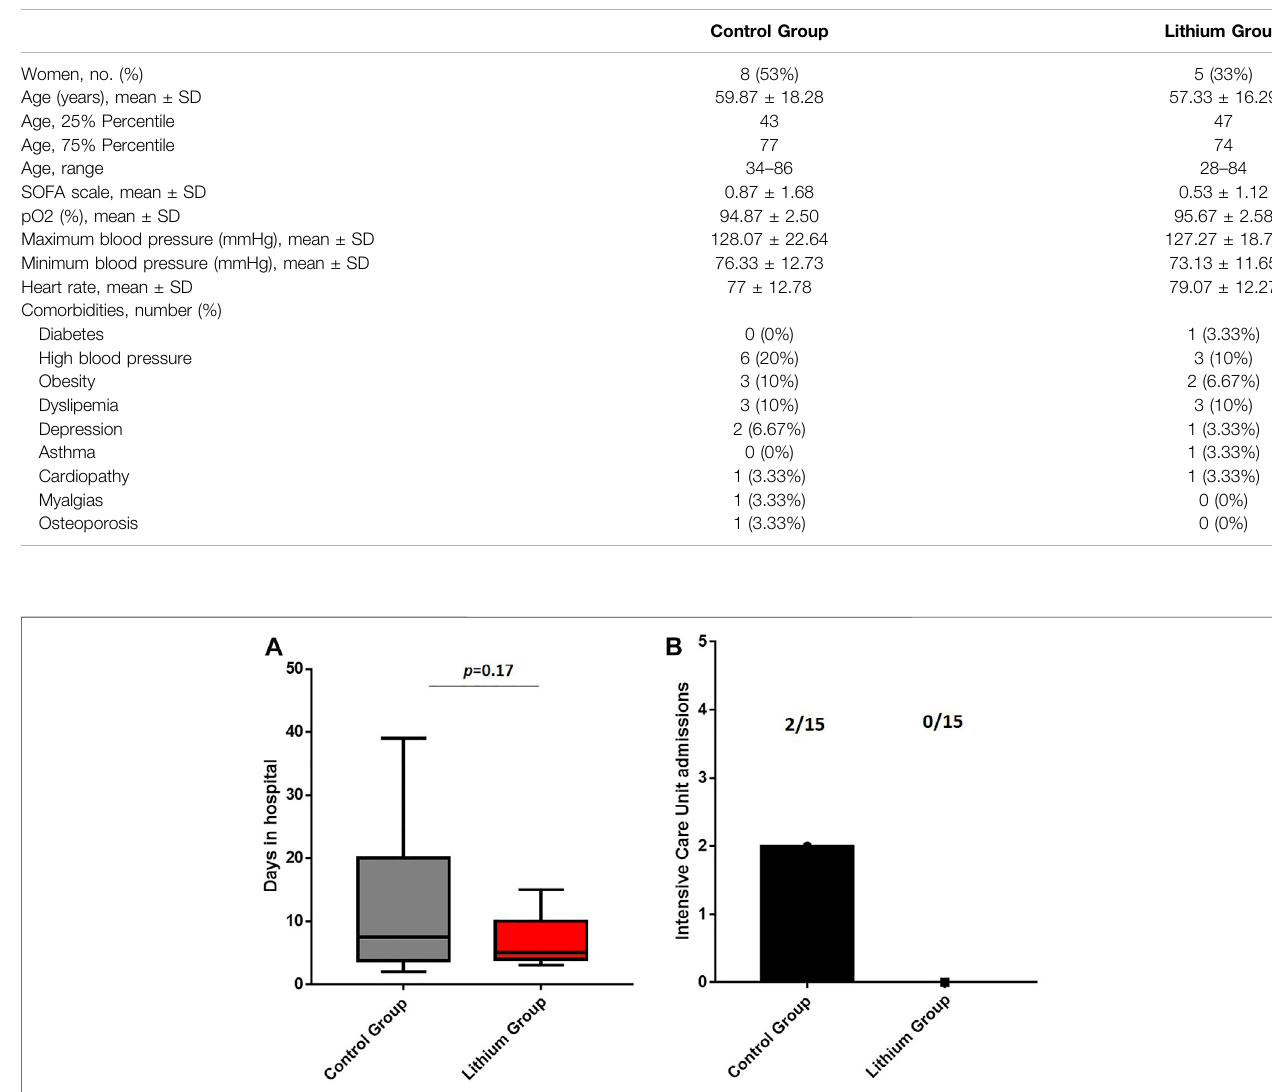
Frontiers in Pharmacology |